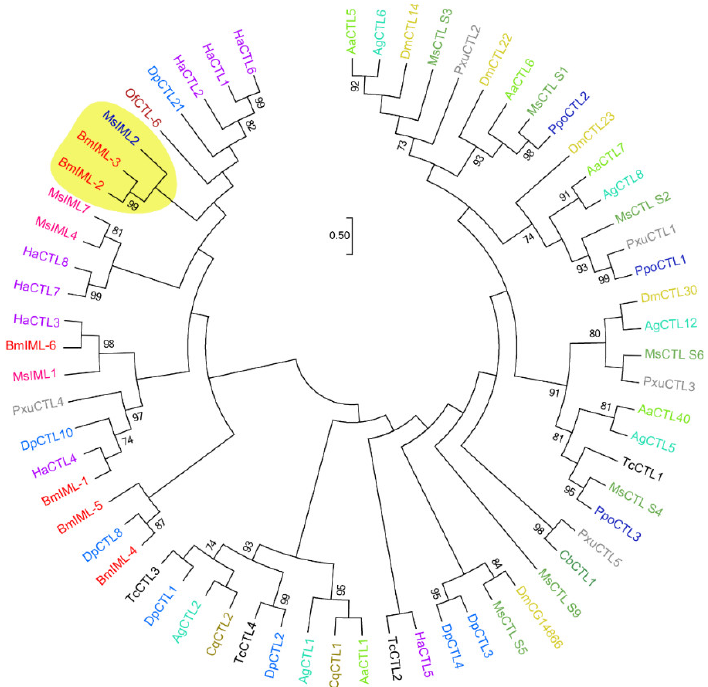
Figure 2. The phylogenetic relationships of B. mori IML-2 with other homologous sequences. The branch containing B. mori IML-2 shown with a yellow background. The numerical values representing bootstrap values only over 70 are marked. The abbreviations are as follows: Aa: A. aegypti ; Ag: A. gambiae ; Bm: B. mori ; Cb: Cerapachys biroi ; Cq: Culex quinquefasciat ; Dm: D. melanogaster ; Dp: D. plexippus ; Ha: H. armigera ; Ms: M. sexta ; Of: Ostrinia furnacalis ; Ppo: Papilio polytes ; Pxu: Papilio xuthus ; Tc: T. castaneum .